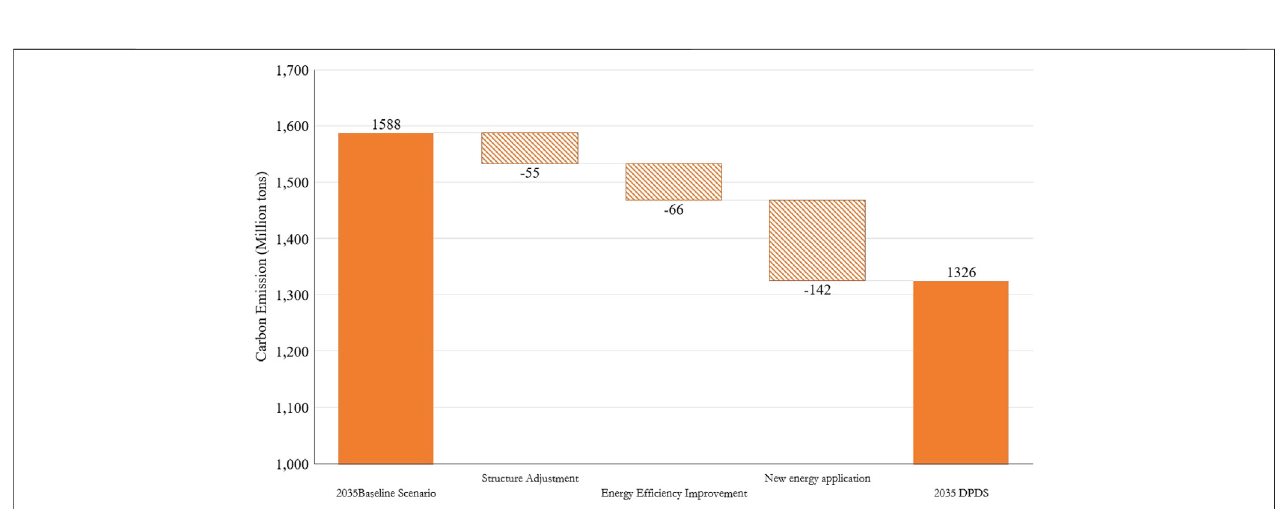
FIGURE 9 | Deconstruction of carbon emissions under the dual carbon policy scenario in 2035.